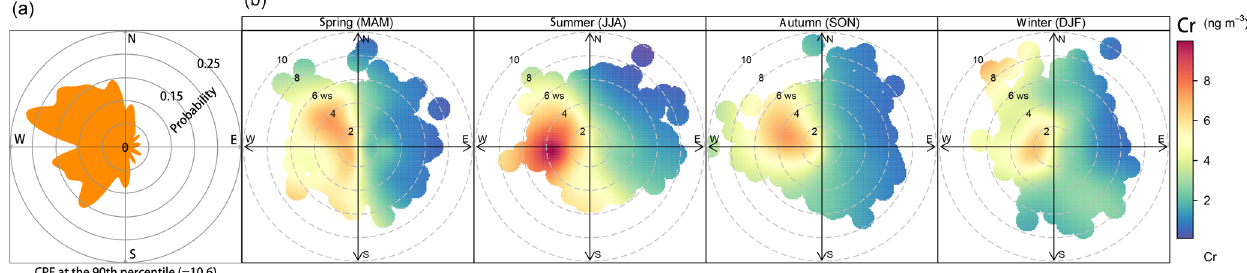
Figure 8. Conditional probability function analysis (a) and bivariate polar plots (b) of seasonal concentrations (in ngm − 3 ) of Cr in Shanghai between March 2016 and February 2017. The center of each plot (centered at the sampling site) represents a wind speed of zero, which increases radially outward. The concentration is shown by the color